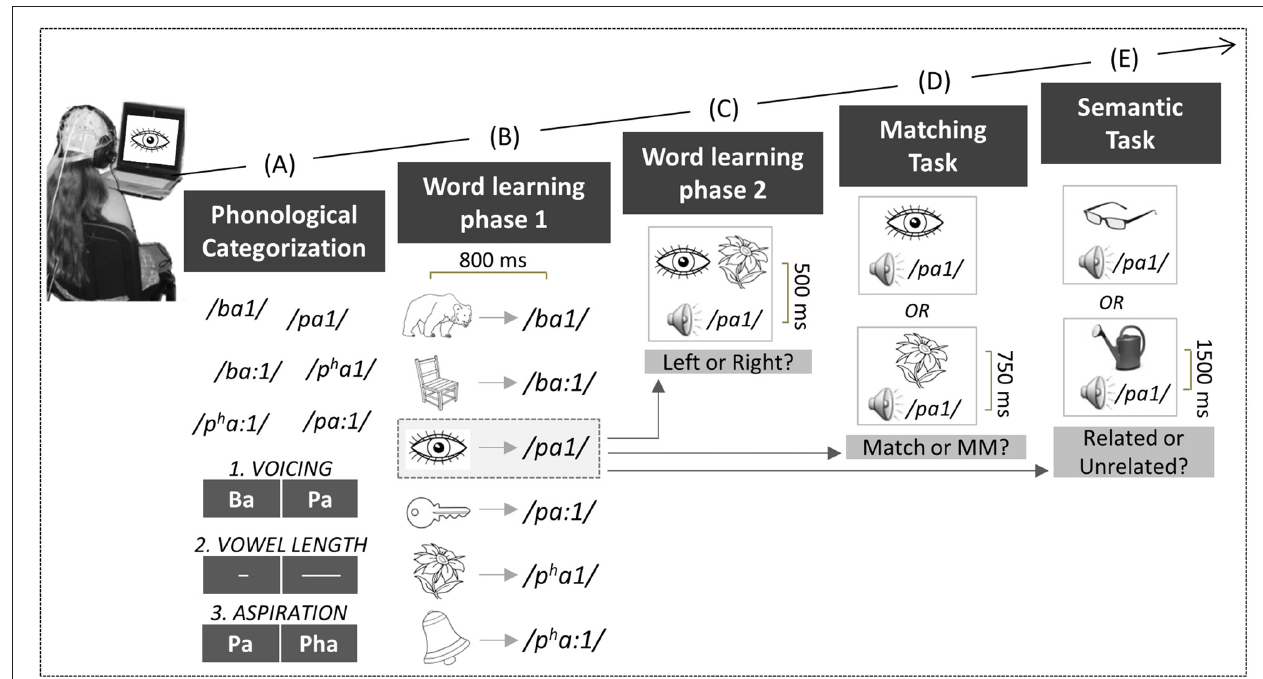
FIGURE 1 | Experimental design . Children performed a series of tasks: First, in the phonological categorization tasks (A) , six natural Thai mono-syllabic words had to be categorized based on voicing (Task 1), vowel length (Task 2), or aspiration contrasts (Task 3). Second, in the word learning phase 1 (B) , each word was paired with its respective picture. Third, in the word learning phase 2 (C) , two of the pictures were presented simultaneously on the screen, together with an auditory word that matched one of the two pictures. Fourth, in the matching task (D) , the auditory words were presented with one of the pictures, either matching or mismatching the previously learned associations. Fifth, in the semantic task (E) , the auditory words were presented with novel pictures that were either semantically related or unrelated to the